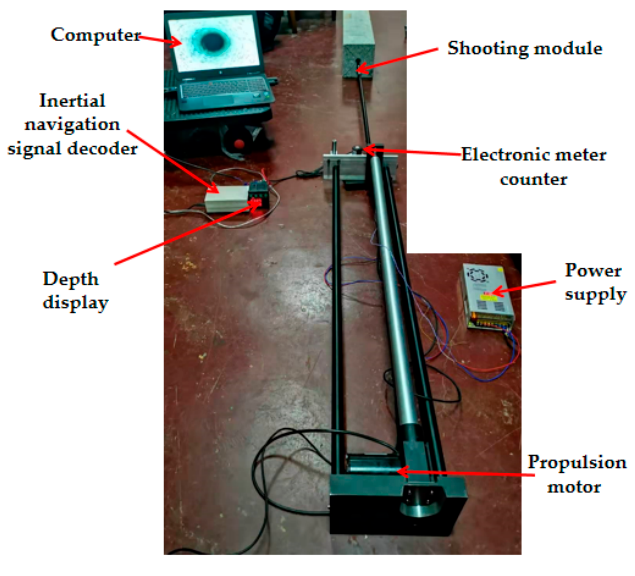
Figure 2. Image of the working system.